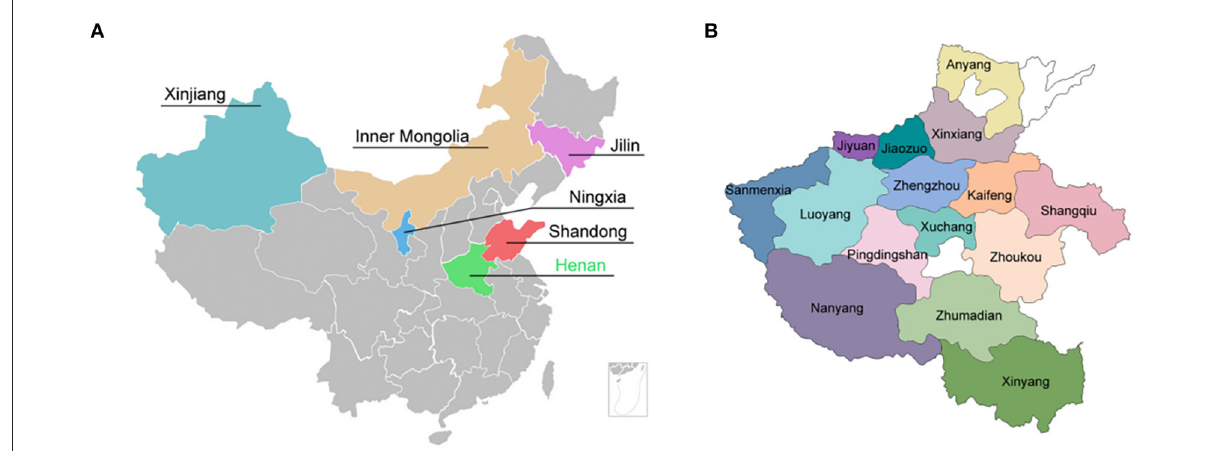
FIGURE1 Geographic localization for specimens collection. (A) Six provinces in China where specimens were collected. (B) 15 regions in Henan Province where specimens were